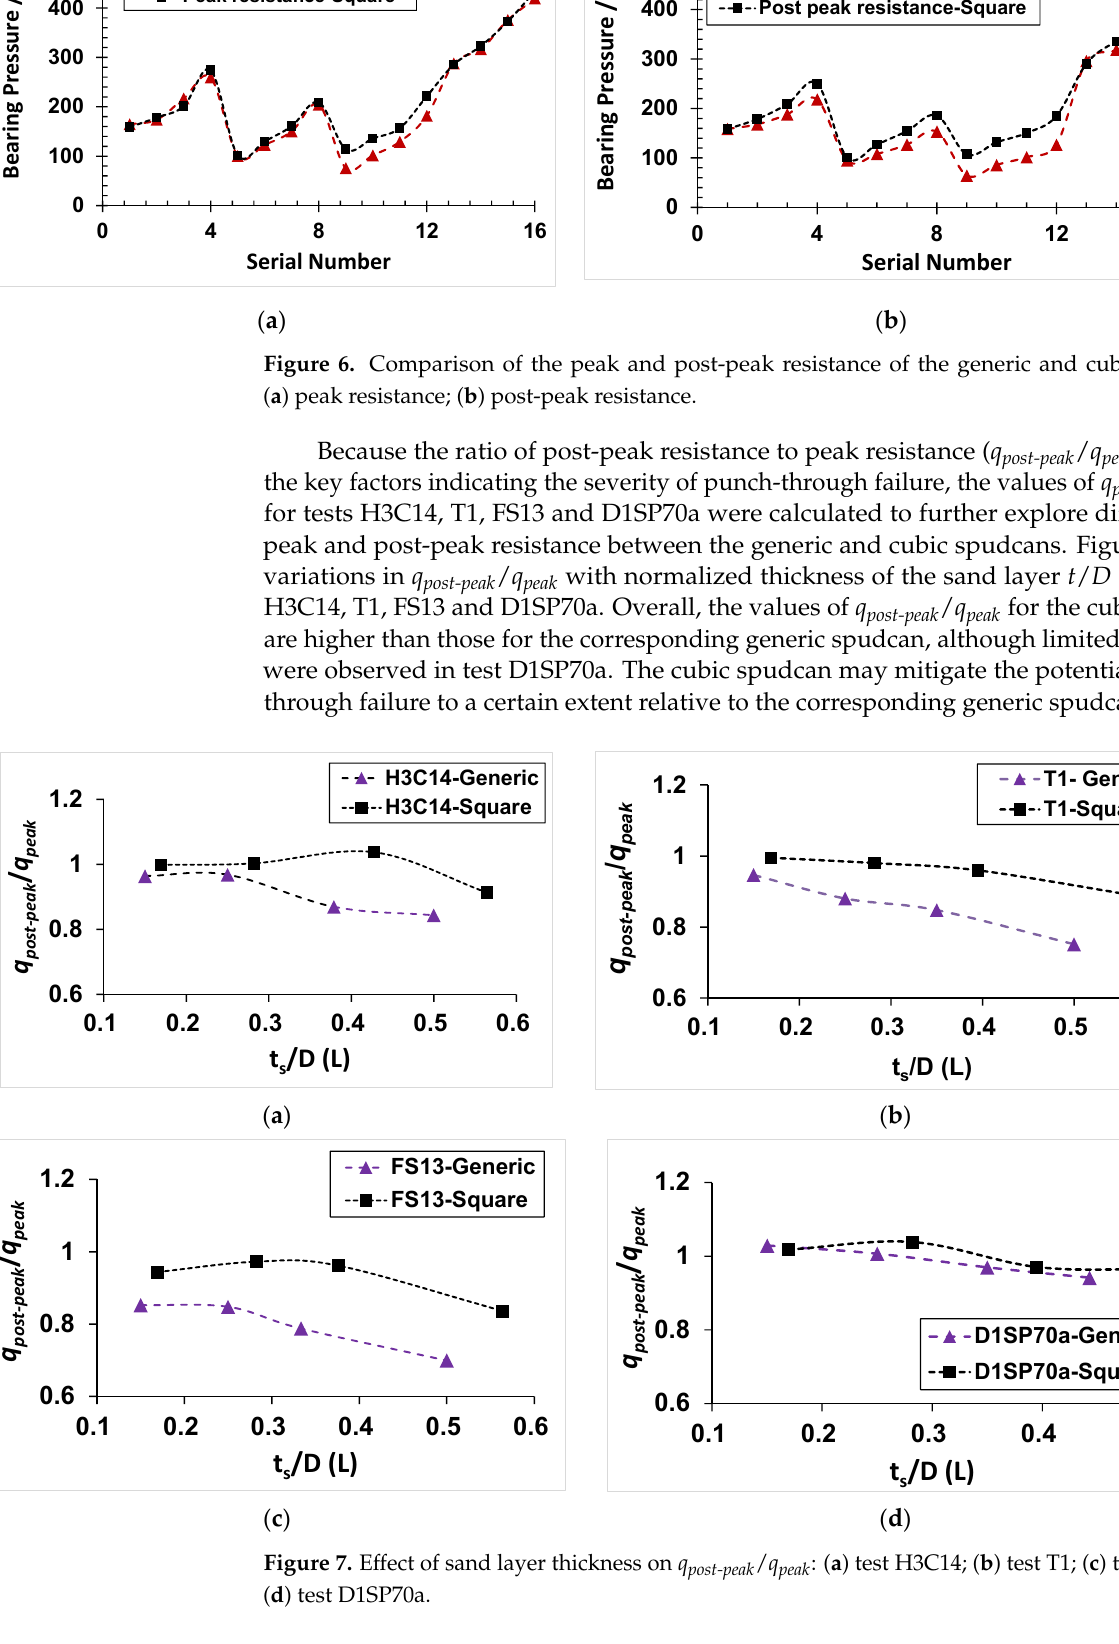
( b ) Figure 5. Comparison of resistance profiles of generic and cubic spudcans: ( a ) test T1 and FS13; ( b ) test H3C14 and D1SP70a. With respect to the performance of the cubic spudcan on dense sand-over-clay sedi- ments, the effects of sand thickness (t/D) on the potential for punch-through failure were